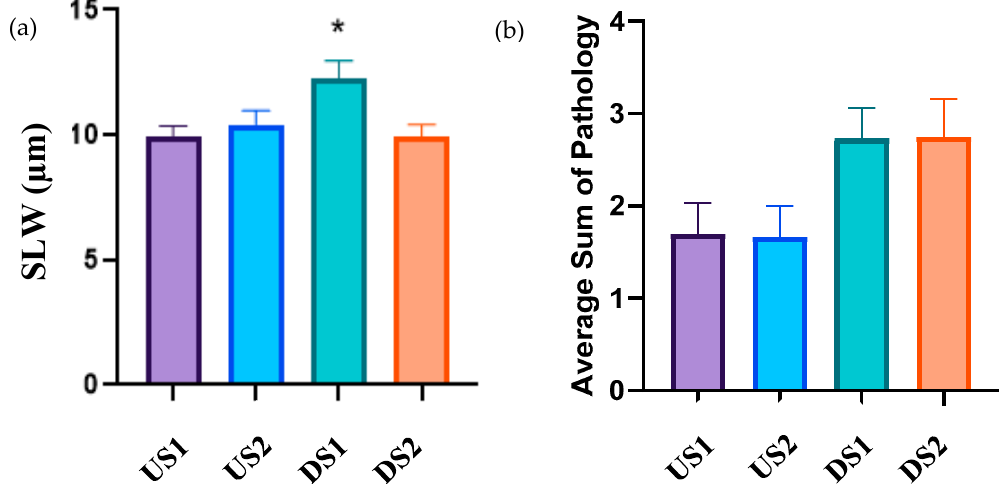
Figure 5. ( a ) The average SLW of the GSDs in summer 2019 ( p < 0.05, n = 11, 8, 24, 11). ( b ) The average pathology scores of the GSDs in summer 2019 ( p < 0.05, n = 11, 8, 24, 11). An asterisk represents a significant difference compared to US1 using a one-way ANOVA and Dunnett’s multiple comparisons test. GSD, greenside darter; US1, upstream 1; US2, upstream 2; DS1, downstream 1; DS2, downstream 2.